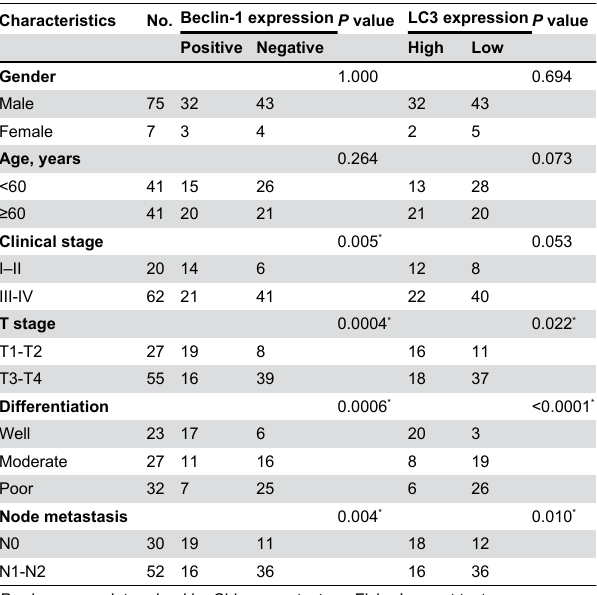
Table 3. Beclin-1 and LC3 expression and patient clinicopathologic characteristics.